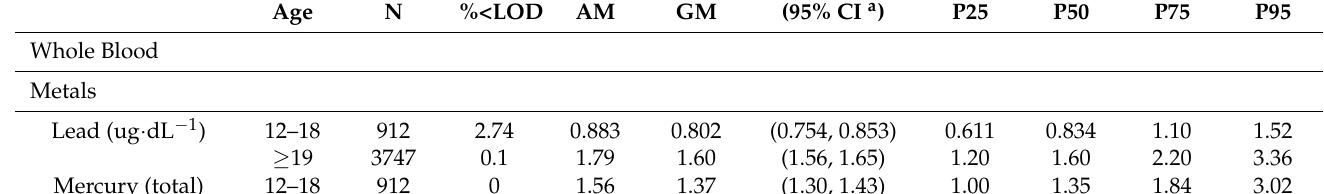
Table 3. Distribution of concentrations of environmental chemicals for the KoNEHS Cycle